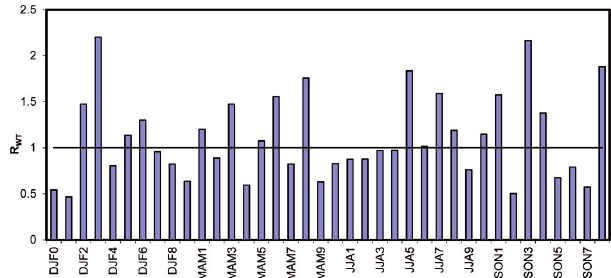
Fig. 4. Backflooding events between 1966 and 2009. Fig. 5. Variability of the Dhuy river flow represented by the R